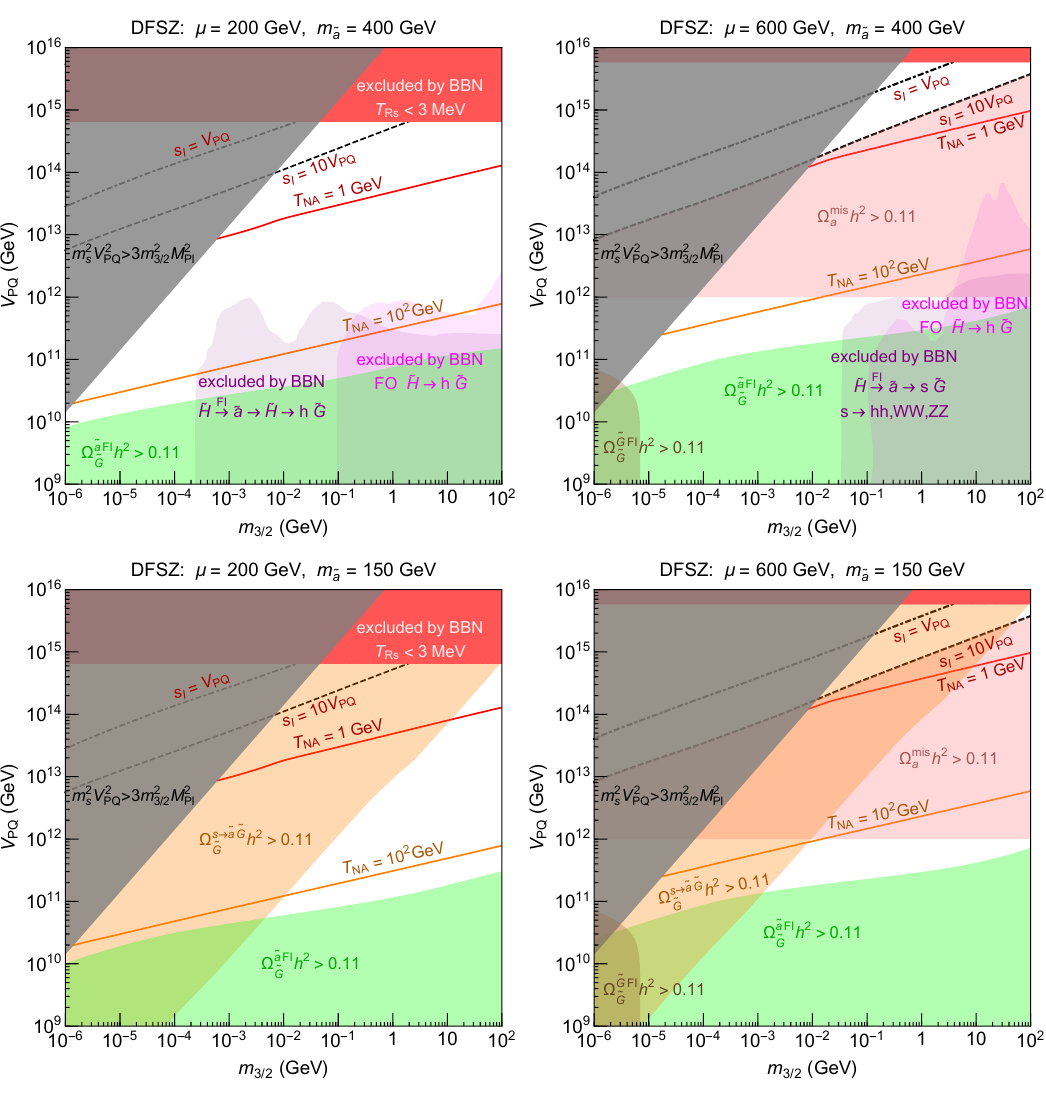
Figure 4 . Constraints on gravitino dark matter in DFSZ theories with saxions of mass m s = 300 GeV decaying dominantly to Higgs and electroweak bosons, for q (cid:22) = 2. For the left (right) two panels (cid:22) = 200 GeV (600 GeV) and we take M 1 ; 2 (cid:22) . In the upper (lower) two panels we take (cid:29) m ~ a = 400 GeV > m s ( m ~ a = 150 GeV < m s ). The axion abundance is computed with N DW =